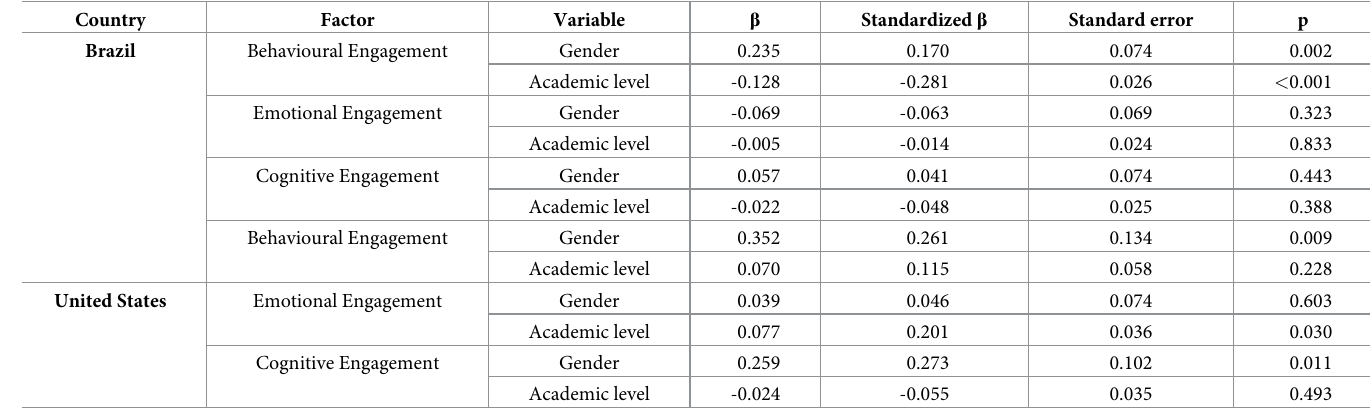
Table 3. Contribution of gender and academic level in the refined reduced USEI factors.